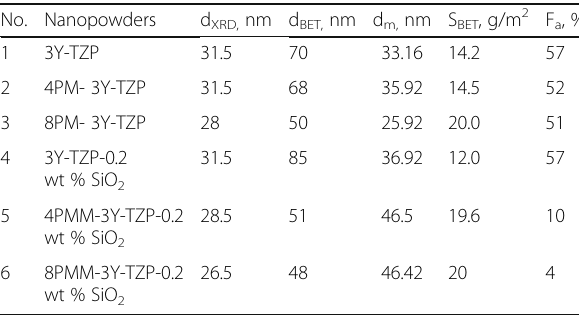
Table 2 The effect of silica additive and mechanical activation on the particle sizes and agglomeration degree (agglomeration factor F a , %) of investigated nanopowders